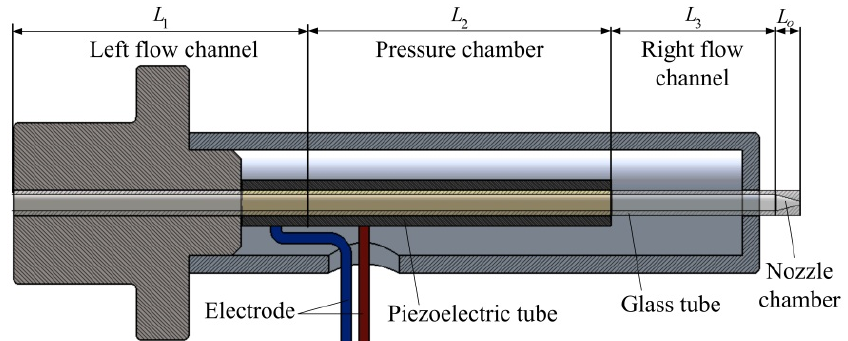
Figure 1. Structure of the MJ-AL-80 PPH.